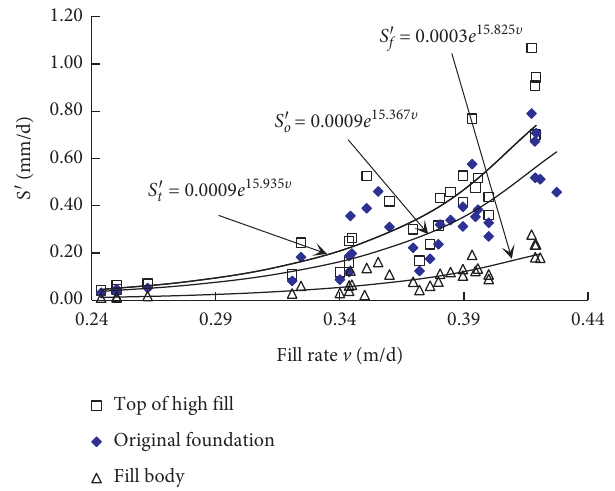
Figure 15: Relationship between PCS rate and fill rate of the high fill surface.